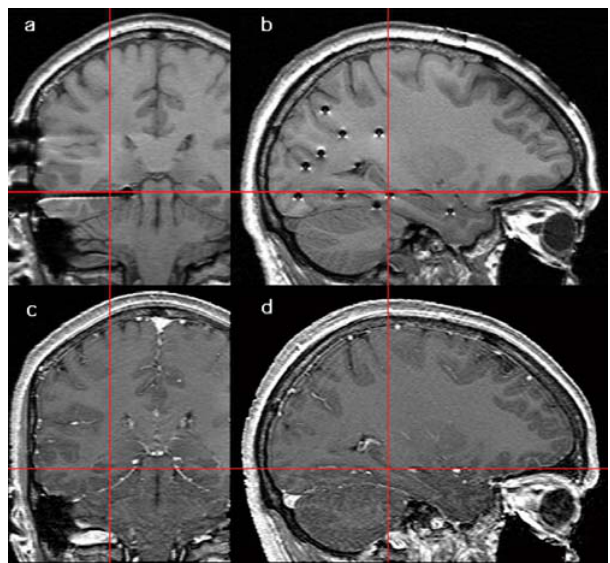
Figure 1. Magnetic resonance imaging (MRI) scan of intracranial electrodes implanted into the medial temporal lobe (a and b panels, coronal and sagittal views, respectively). Red line cross indicates the location of the two electrode contacts within the hippocampus. C and d panels show the MRI scan of the same locations before the electrode